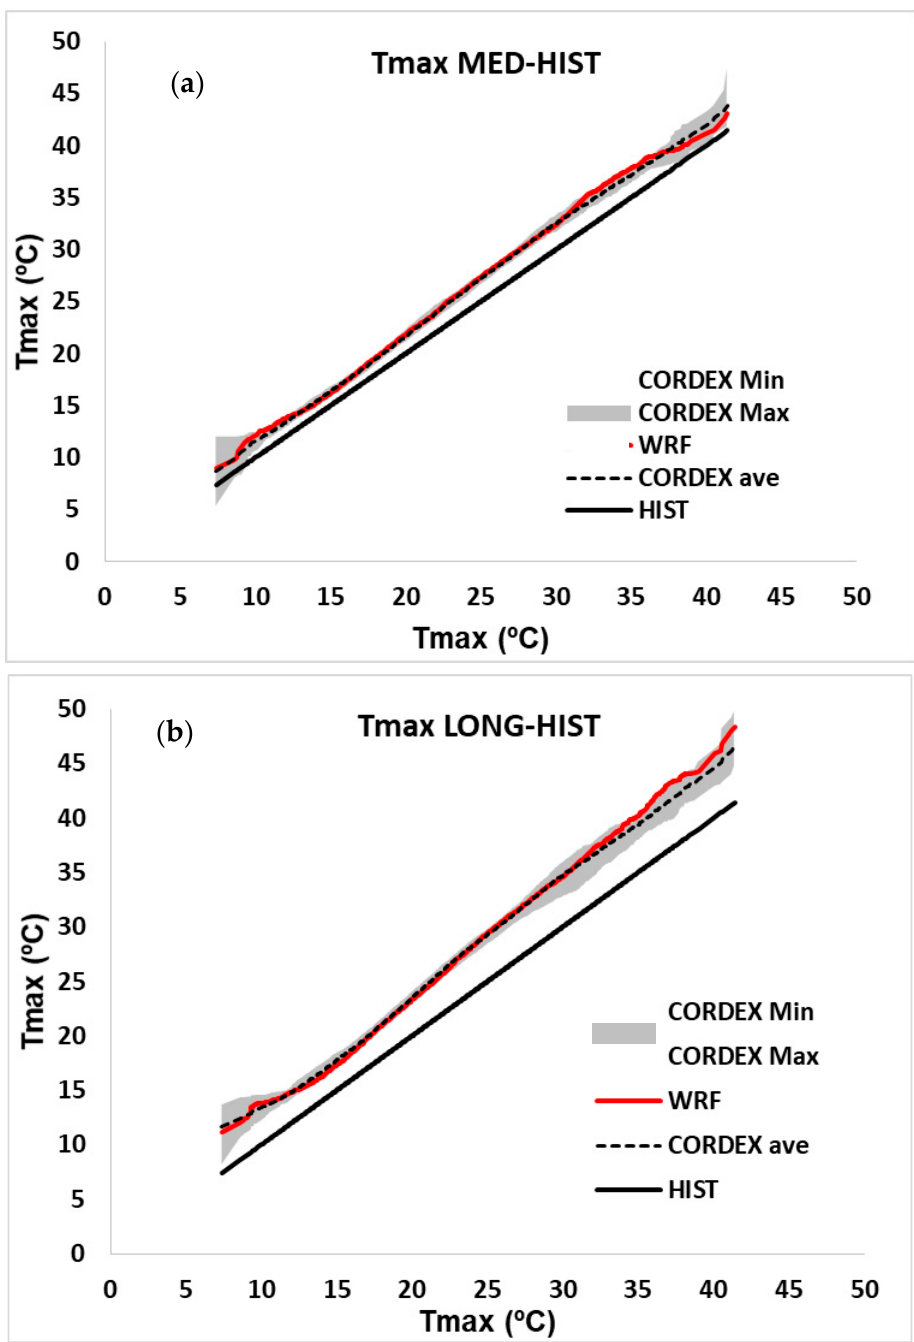
Figure 8. Quantile–quantile graph of Tmax for WRF HIST (horizontal axis) and WRF ( a ) MED and ( b ) LONG, and CORDEX average, maximum, and minimum (vertical axis). LONG: The same as MED but for the 2081–2100 period.